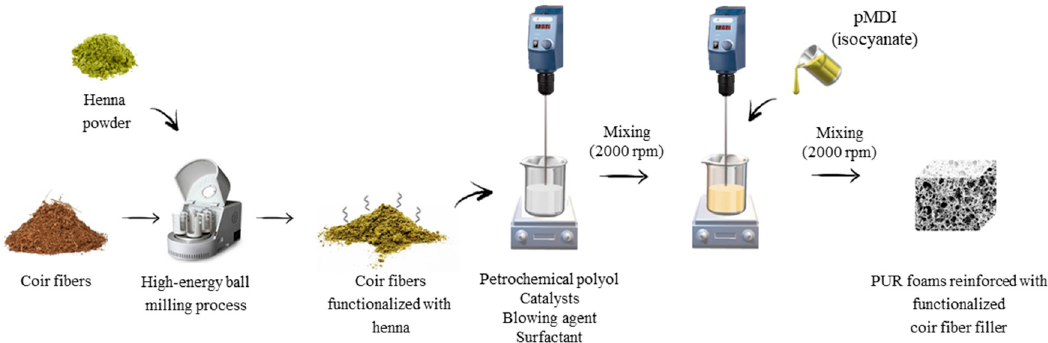
Figure 1. Schematic procedure of PUR composite preparation.